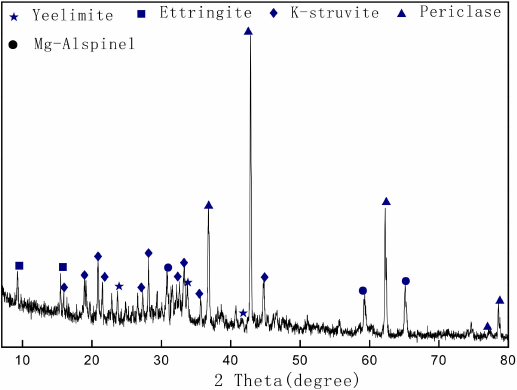
Figure 8. XRD pattern of SAC-MKPC paste after 28 days of